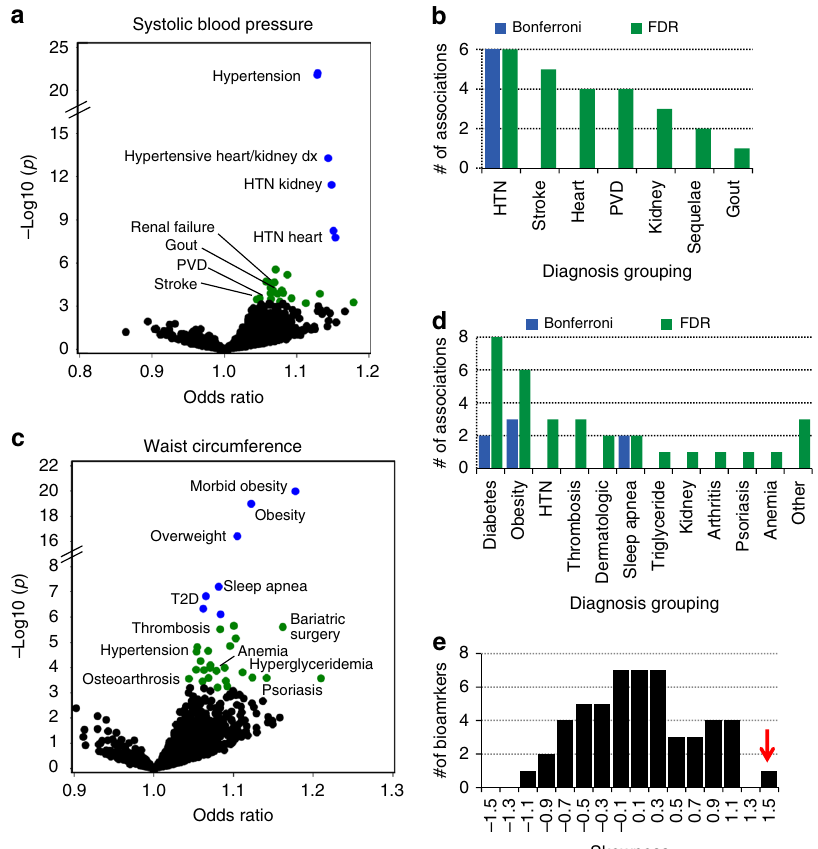
Fig. 3 Comparison of an FDR versus Bonferroni p value selection threshold. a Scatter plot summarizing pheWAS analyses for a genetic predictor of systolic blood pressure (SBP). Each point indicates a logistic regression association analysis, adjusted for birth decade, sex, and 3 PCs, between genetically predicted waist circumference and a pheWAS phenotype. Odds ratios are per standard deviation increase in the genetic predictor. Blue and green colored circles denote associations that are signi fi cant at Bonferroni p < 0.05 and FDR q < 0.1, respectively. Only selected points are labelled for clarity. b Count of the number of associations, binned by disease, meeting a Bonferroni, and FDR selection thresholds. c PheWAS associations for a waist circumference genetic predictor and d count of disease associations signi fi cant by Bonferroni or FDR criteria. e Frequency histogram of the skewness (see Methods for calculations) of the pheWAS beta coef fi cients for each of the 53 biomarkers. The red arrow points to the value for waist circumference. HTN: hypertension; PVD: peripheral vascular disease; T2D: type 2